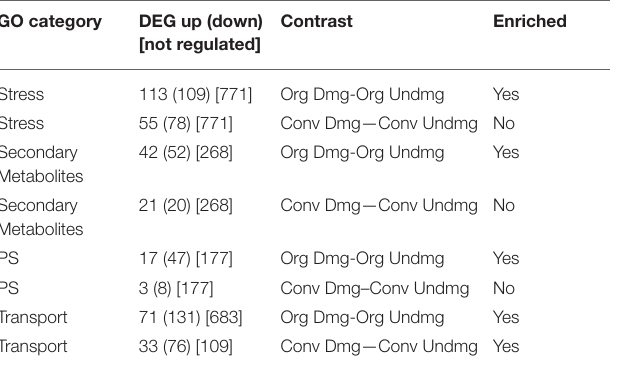
TABLE 1 | Number of differentially expressed genes (DEG) in Norkotah with threshold of adjusted P -value < 0.1, categorized by Gene Ontology (GO) and compared via contrasts (see Supplemental Table 3 ).